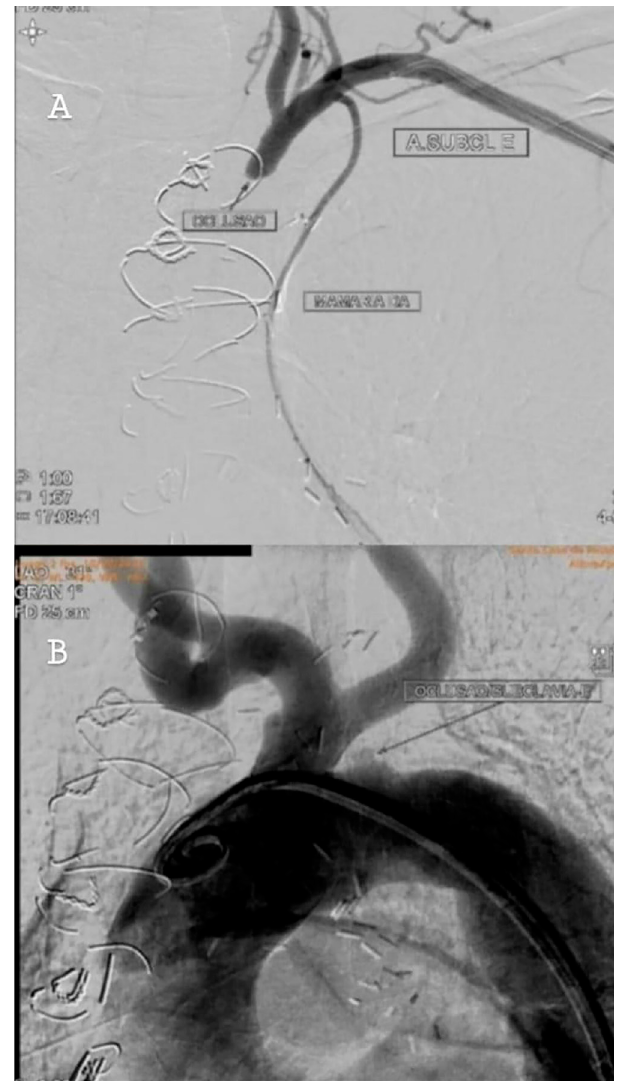
Fig. 1 – (A) Angiography of left vertebral artery and LIMA showing occlusion of the LSA. (B) Angiography of the aortic arch showing occlusion of the LSA. LSA = left subclavian artery